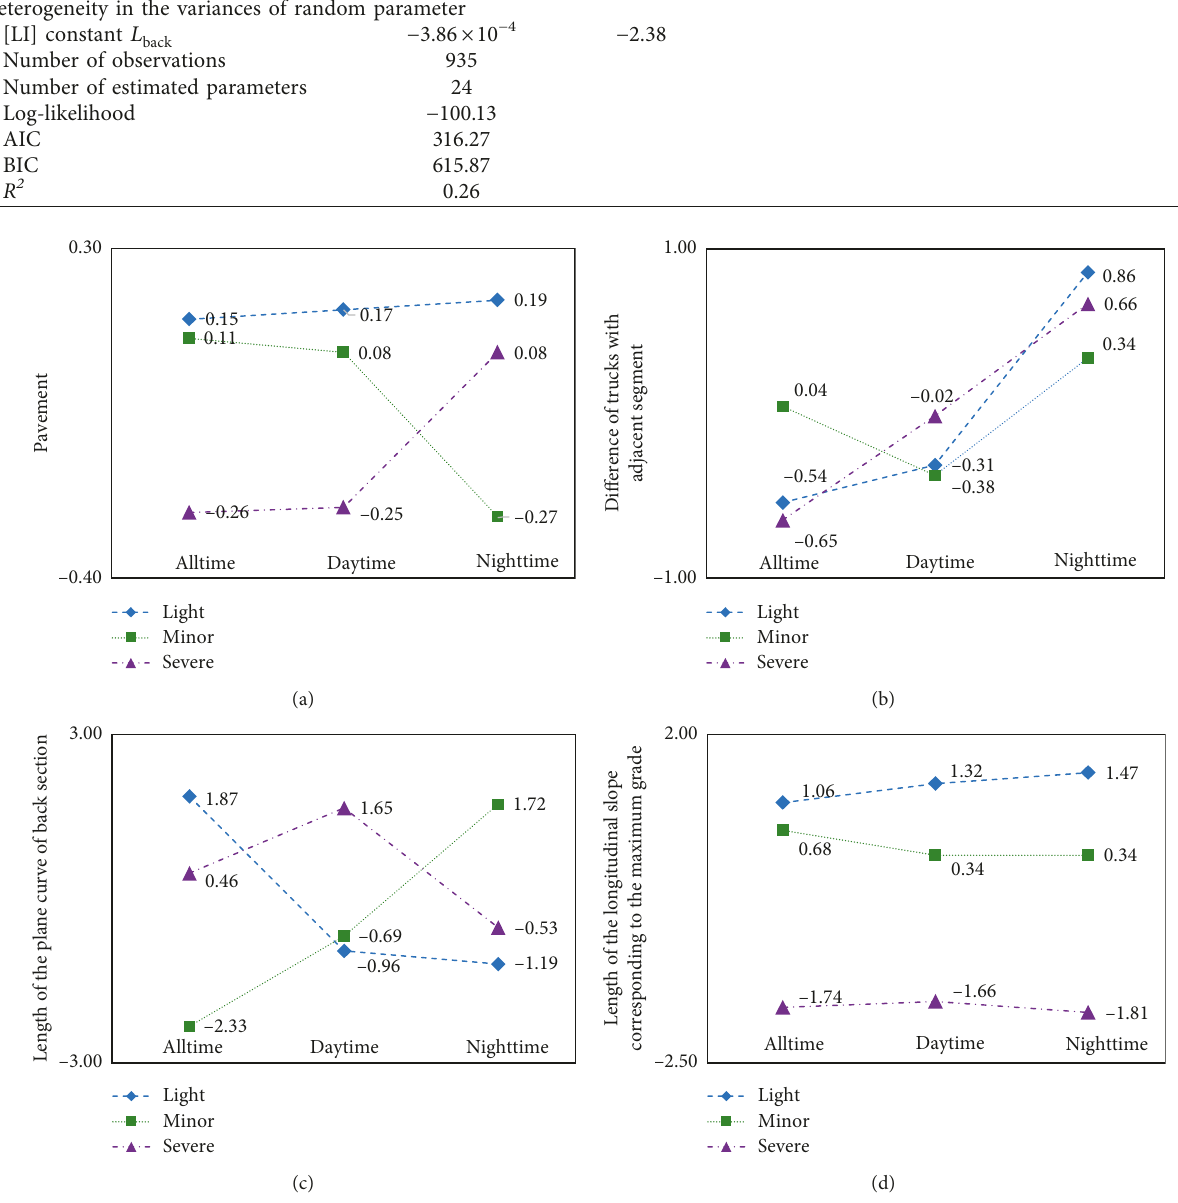
Figure 1: 95% confidence interval of the elasticity effects of contributing factors on crash severity. (a) Pavement (10 − 2 ), (b) speed difference of trucks with adjacent segment ( Δ V O − longitudinal slope corresponding to the maximum grade ( LS